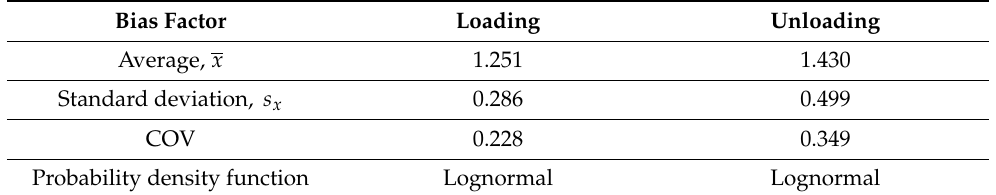
Table 5. Variability analysis of the bias factor of vertical earth pressure under the loading and unloading